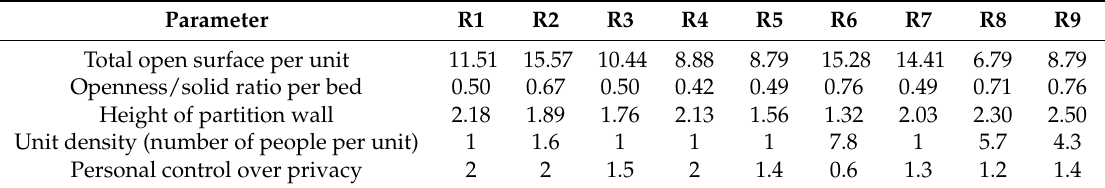
Table 2. Mean value of five parameters measured in C&A homes.